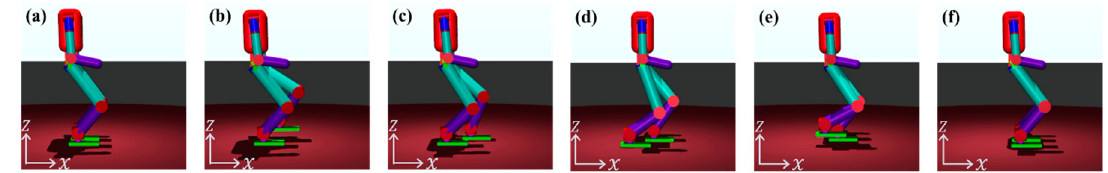
Figure 2. Forward walking. ( a ) Initial position, ( b ) left foot lifting, ( c ) left foot lowering after swing, ( d ) center-of-mass forward displacement, ( e ) right foot lifting, and ( f ) motion completion.